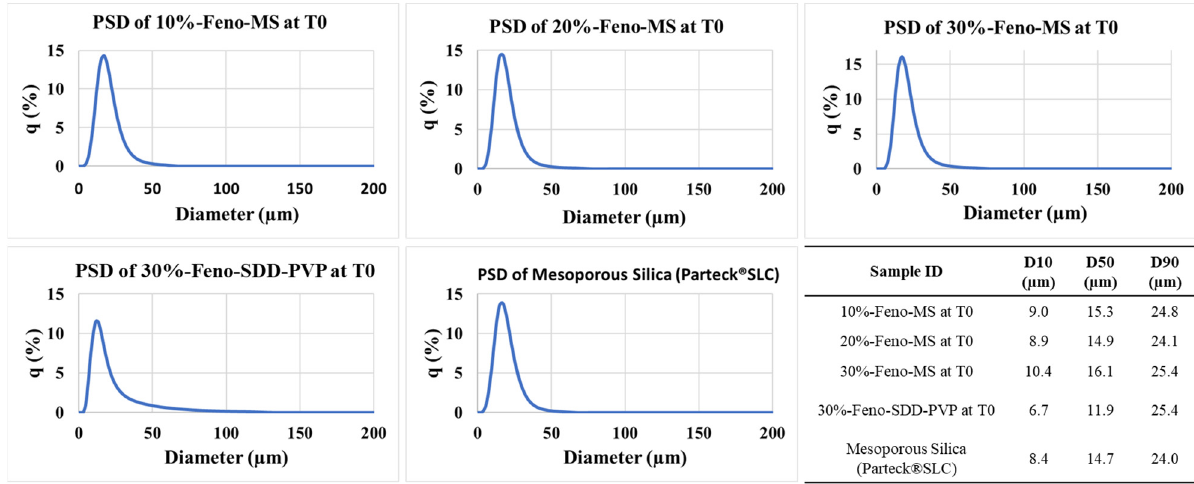
Figure 3. PSD profiles of Feno-MS samples at drug load of 10%, 20%, and 30% at T0, 30%-Feno-SDD- PVP at T0, and mesoporous silica (Parteck ® SLC).